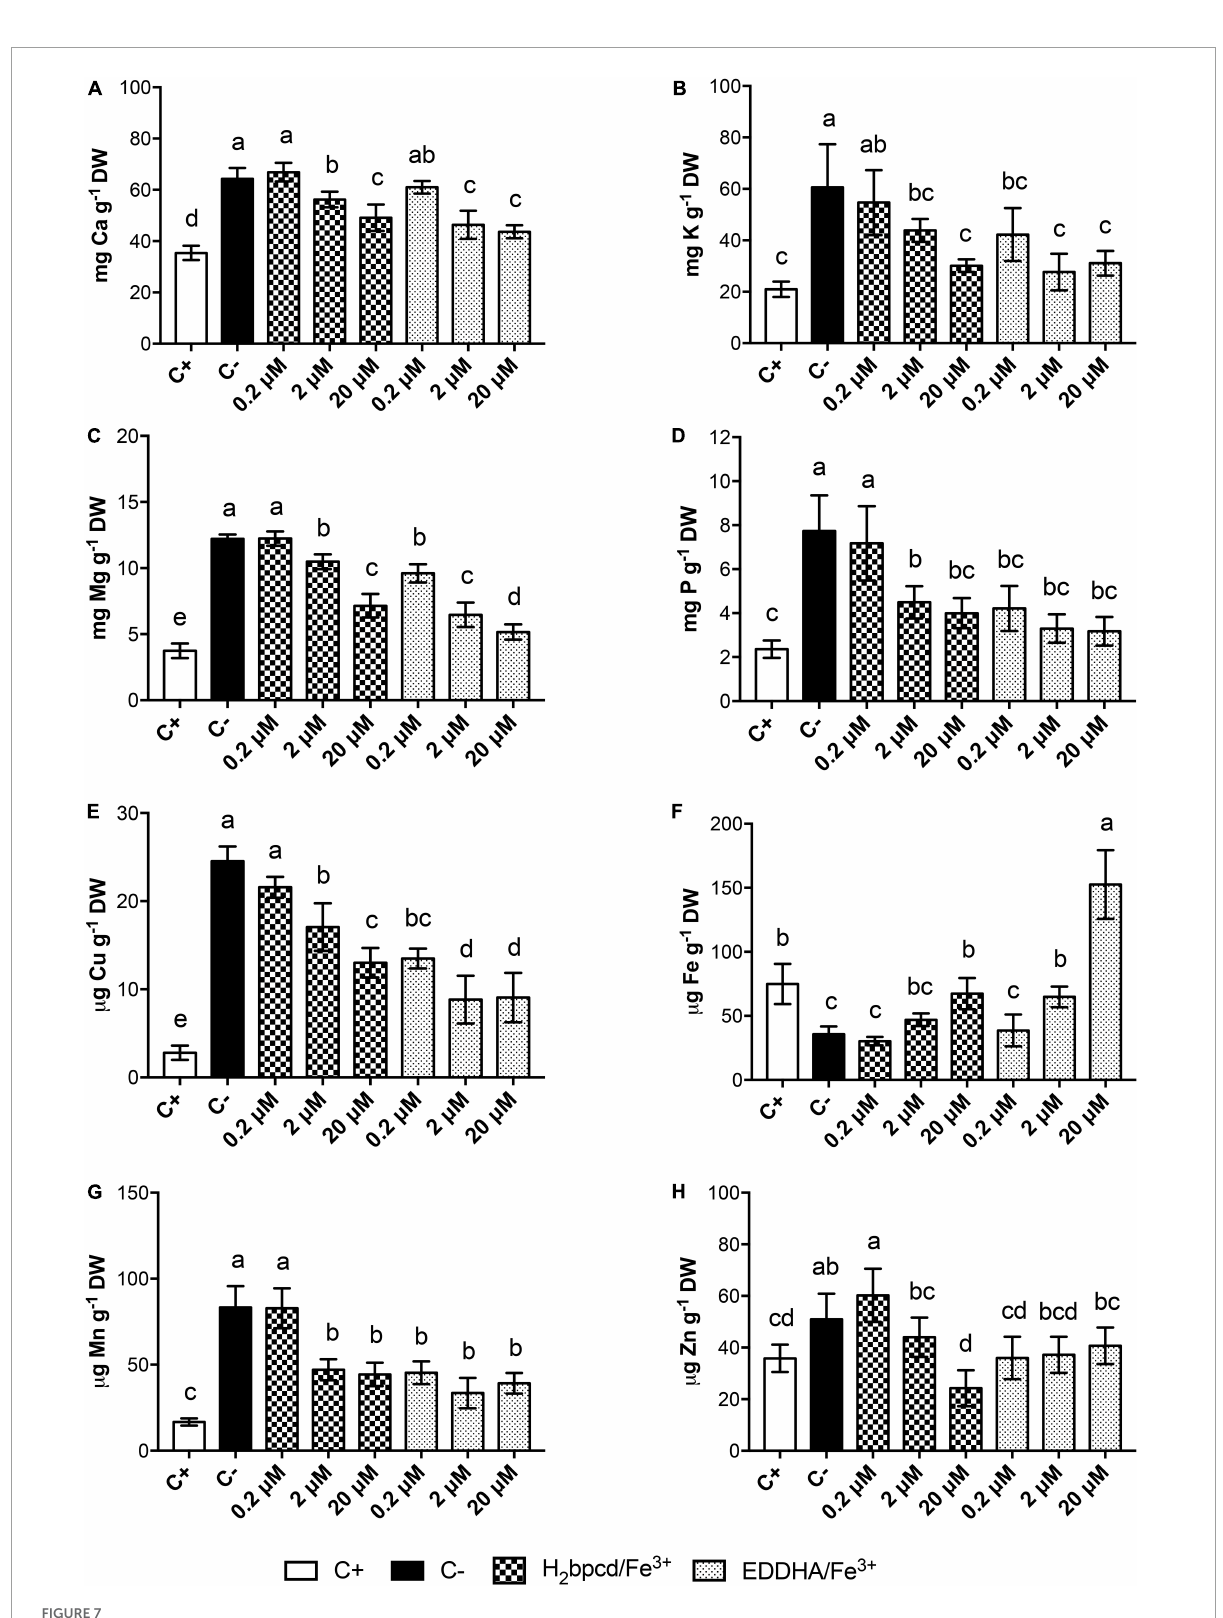
FIGURE7 Macro- and micronutrient content in shoot tissues of Fe-deficient cucumber plants supplied with H 2 bpcd/Fe 3 + and EDDHA/Fe 3 + for 7 days. Shoot content of (A) Ca, (B) K, (C) Mg, (D) P, (E) Cu, (F) Fe, (G) Mn, and (H) Zn. Data represent mean ± S.D. of three independent replicates with two plants each ( n = 6) (one-way ANOVA with Turkey’s post hoc test, p < 0.05, significant differences are indicated by different